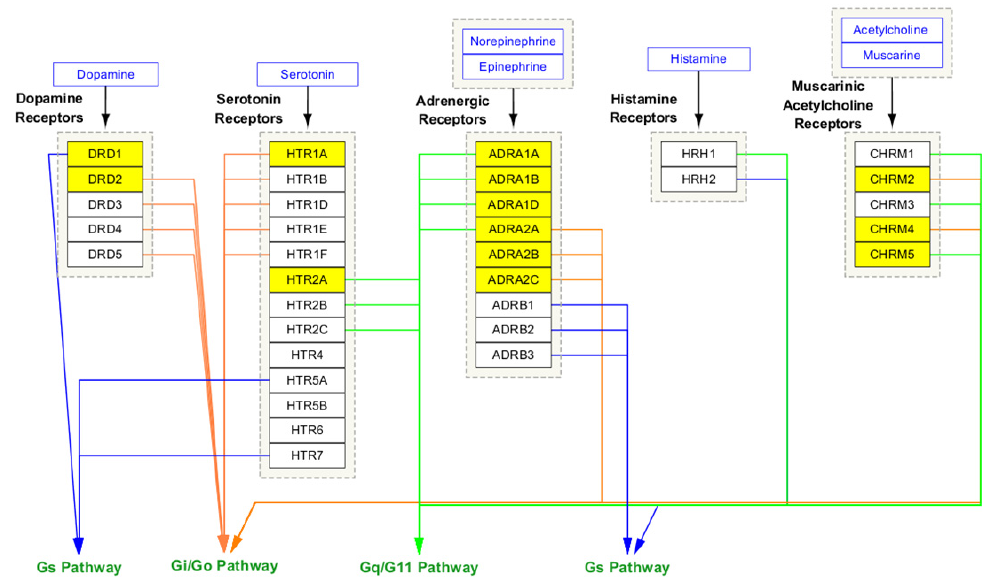
Figure 7. Detailed analysis of the 13 out of the 23 screened genes in “monoamine GPCRs” pathway. The 13 genes are highlighted, and they are distributed in categories of adrenergic receptors, dopamine receptors, serotonin receptors, and muscarinic acetylcholine receptors, but not in histamine receptors. Arrows: blue, Gs pathway; orange, Gi/Go pathway; green, Gq/G11 pathway.